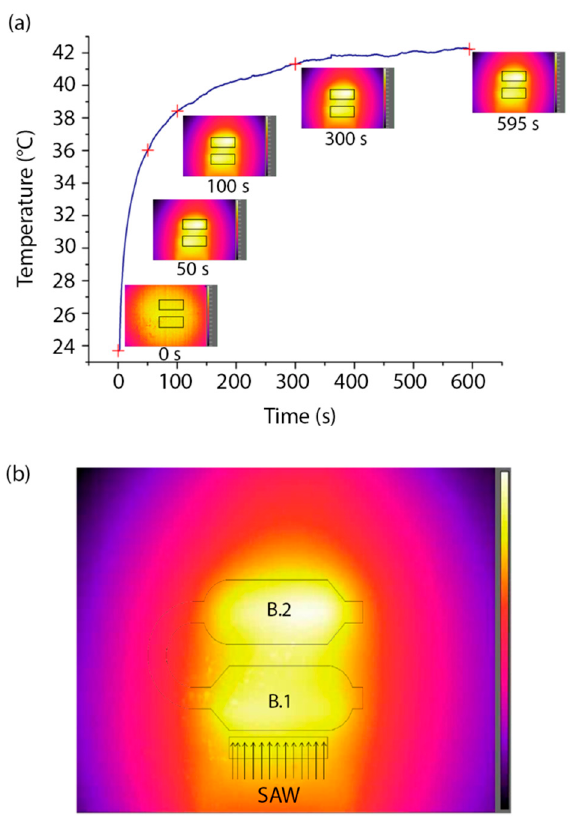
Figure 6. Thermal measurements in the presence of SAWs. ( a ) Heating of the LN substrate versus time (SAW activation at t = 0). The insets show five images from the thermal camera at t = 0 s, 50 s, 100 s, 300 s and 595 s, with the regions of interest (ROIs) used for calculating the average substrate temperature. ( b ) Temperature profile of the LN substrate at thermal equilibrium after SAW generation. A schematic of the microchannel is superimposed to the image. SAW direction from IDT is specified by the arrows. Color bar ranges from 28.8 °C to 42.0 °C.